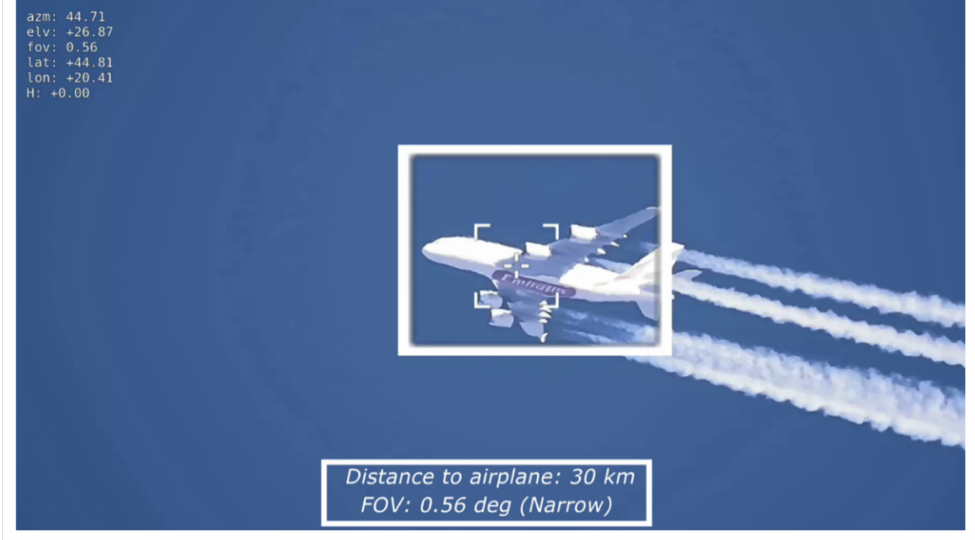
Figure 21. Long-distance target